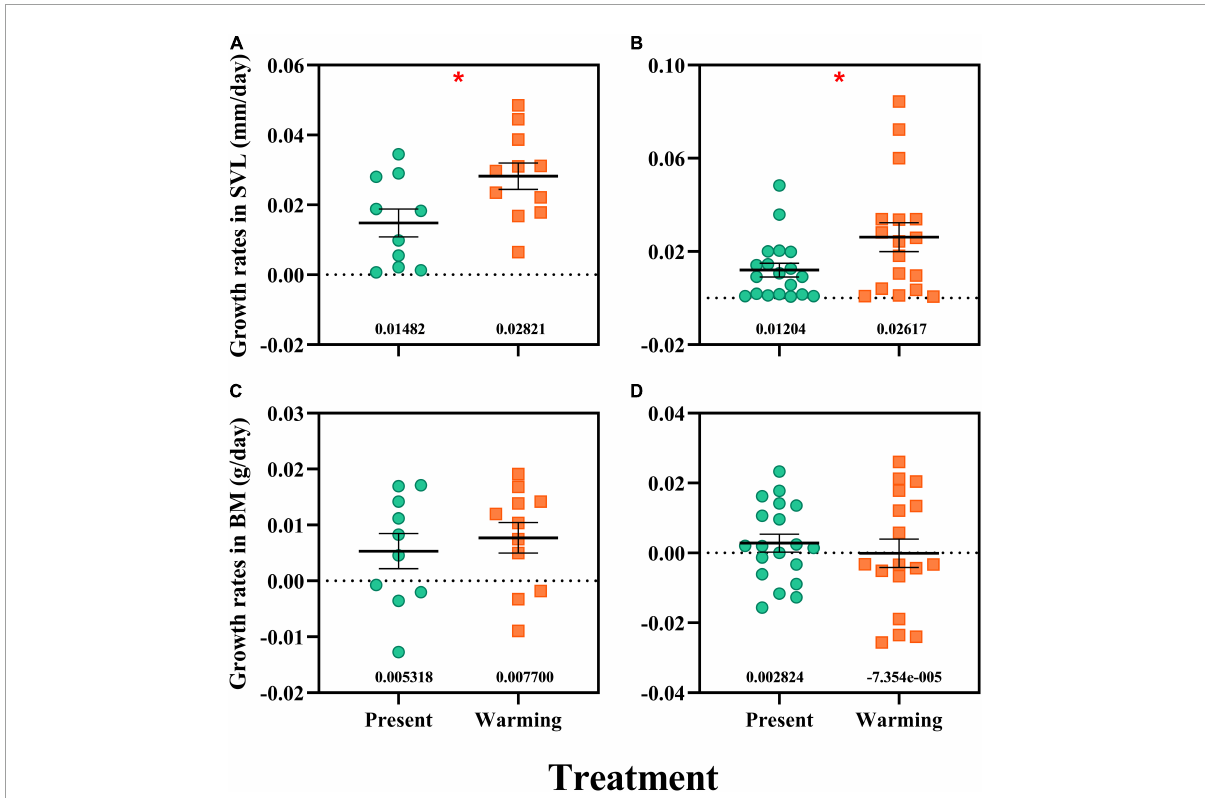
FIGURE3 Growth rates in snout-vent length (SVL) and body mass (BM) of Eremias argus (A,C) and Takydromus amurensis (B,D) . Each dot indicates an individual; the green and orange dots indicate the present and warming climate conditions, respectively. Data are shown as mean ± standard error (SE). *Asterisk indicates significant differences between present and warming climate conditions.